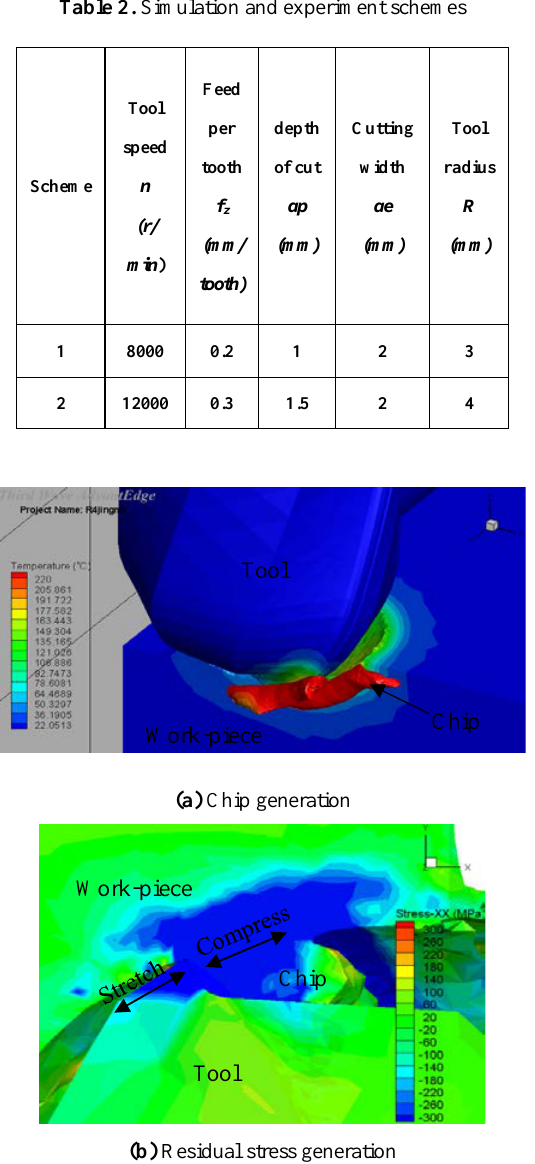
Fig. 2. Simulation model